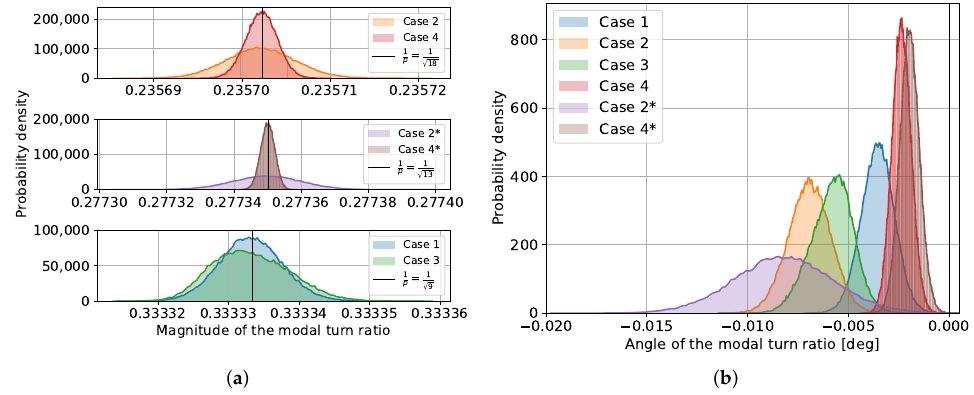
Figure 10. Magnitude and angle distributions of the modal turn ratio p from Monte Carlo simulations. ( a ) Magnitude distributions. ( b ) Angle